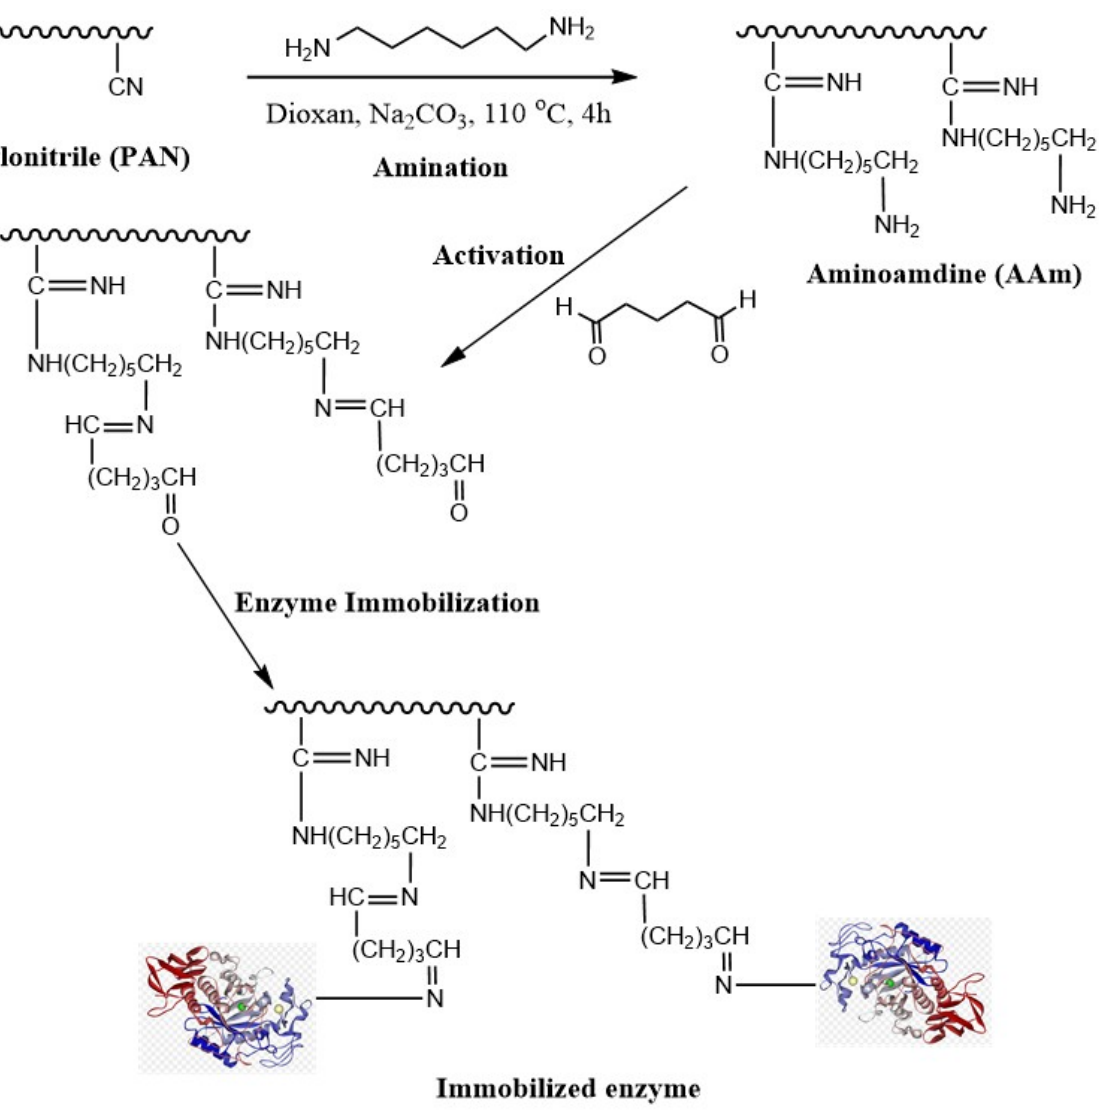
Figure 1. Schematic representation of the modified PAN and immobilized lipase.